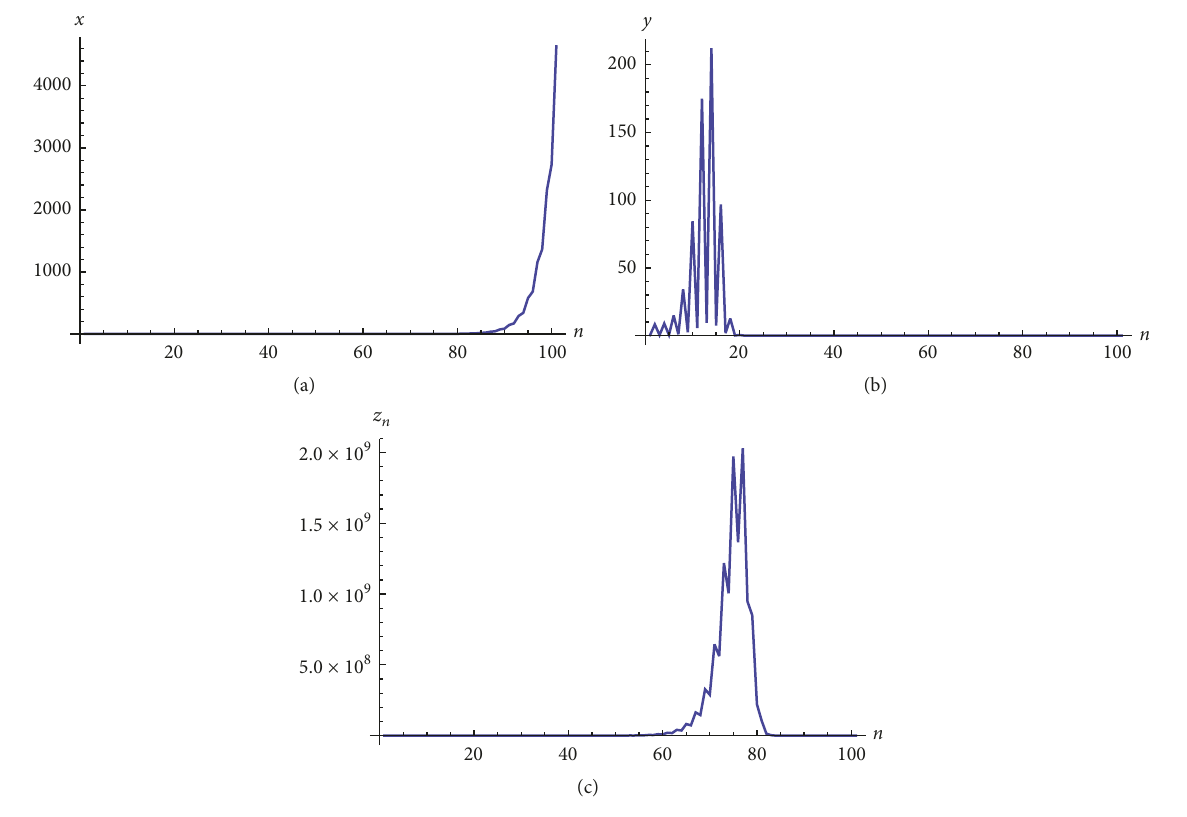
Figure 3: Phase portrait of